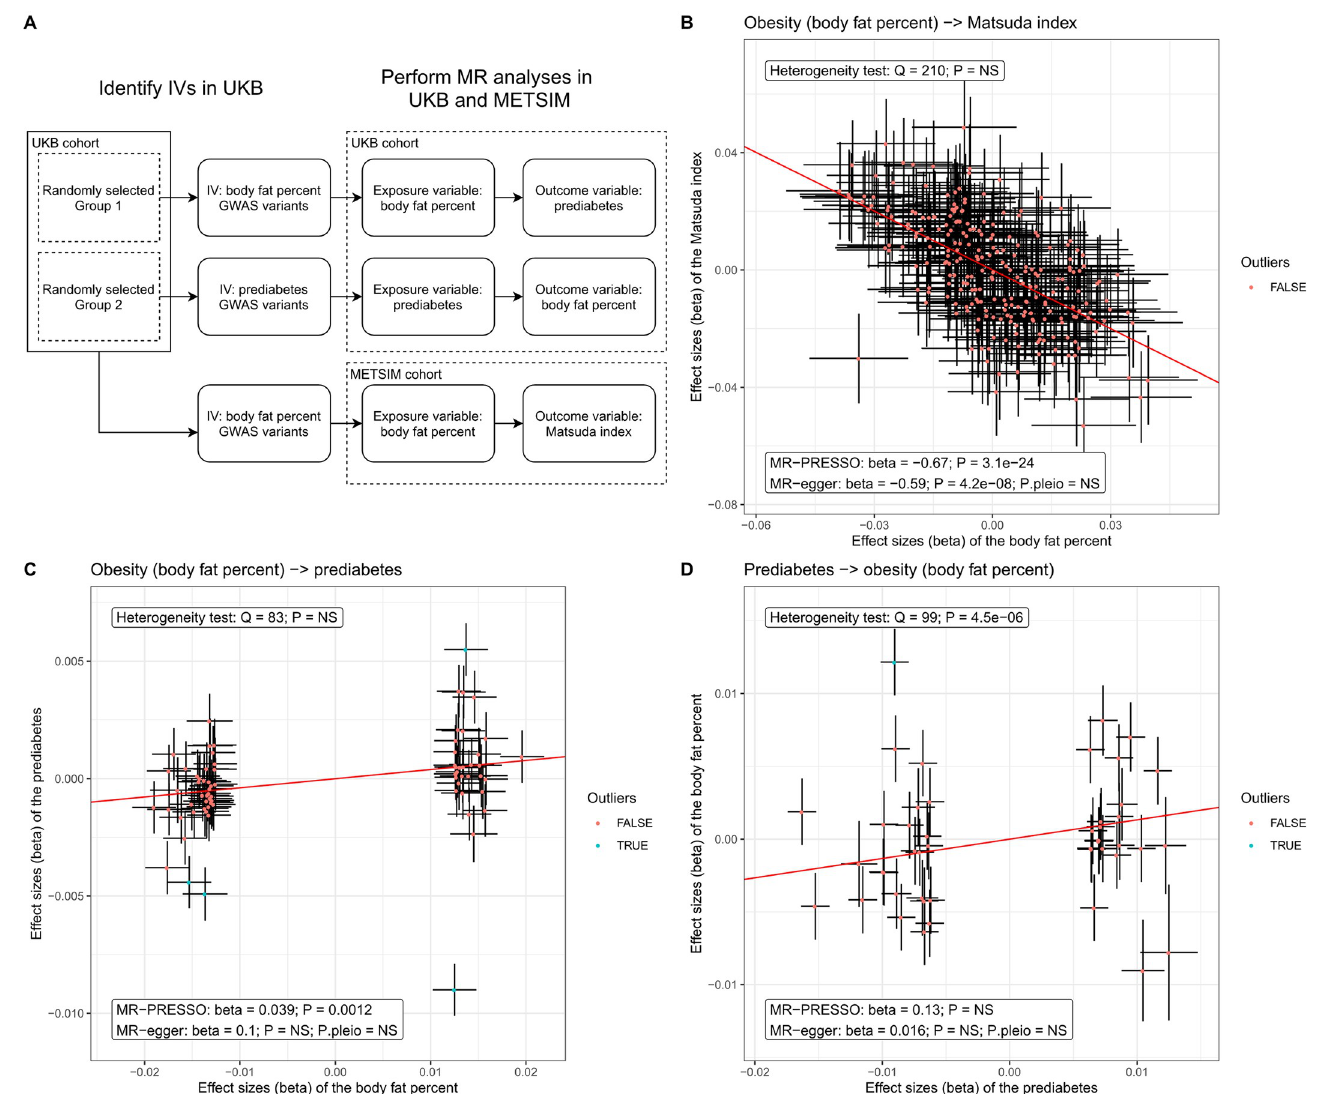
Fig 1. MR analysis shows the causal relationship of body fat percent on prediabetes and Matsuda index, i.e. obesity leads to insulin resistance. (A) Workflow of our MR analysis in UKB and METSIM cohorts. (B) The variant effect sizes on the exposure (i.e. body fat percent) are associated with the variant effect sizes on the outcome (i.e. the Matsuda index). The slope indicates the estimated causal effect of the exposure on the outcome. The label boxes showed the MR results after MR-PRESSO adjusted for potential pleiotropy. P.pleio indicates the p-value of pleiotropy identified by MR-egger. The IVs are significant body fat percent GWAS variants in UKB (see the Methods for details). (C) A two-sample MR analyses show the causal effect of obesity (i.e. body fat percent) on prediabetes in UKB cohort. The IVs are significant prediabetes GWAS variants in UKB (see the Methods for details). (D) A two-sample MR analysis did not identify the causal effect of prediabetes on obesity (i.e. body fat percent). The p-values of the causal effects from MR-PRESSO and MR-egger were adjusted for 3 tests using a Bonferroni correction. To keep a stringent control of the potential pleiotropy, the other p-values (Heterogeneity test and P.pleio) were not adjusted for multiple testing. NS indicates a non-significant p-value (p-value > 0.05). The IVs are significant body fat percent GWAS variants in UKB (see the Methods for